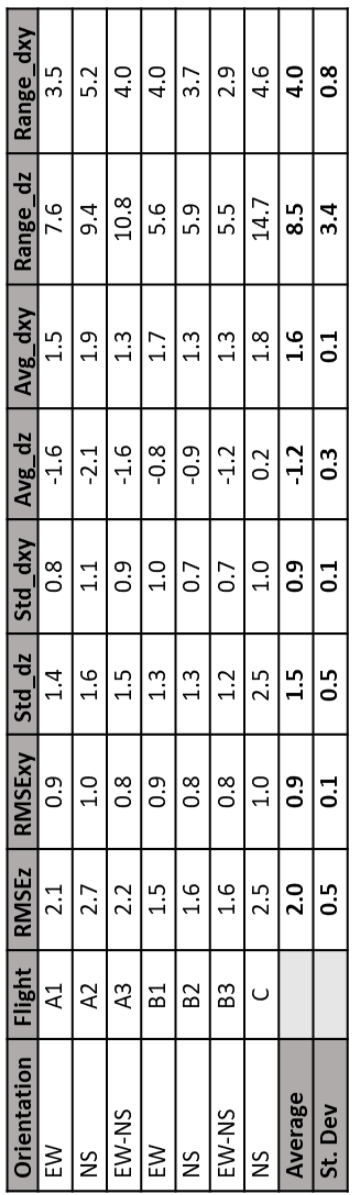
Table 3. Results of DEM analysis at 75 checkpoints for